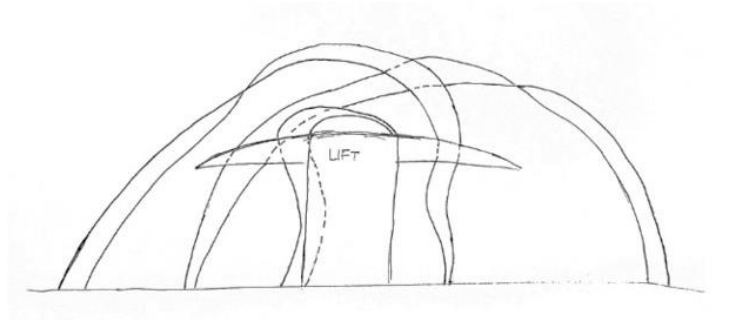
Fig. 4 First design sketch of the entrance portal